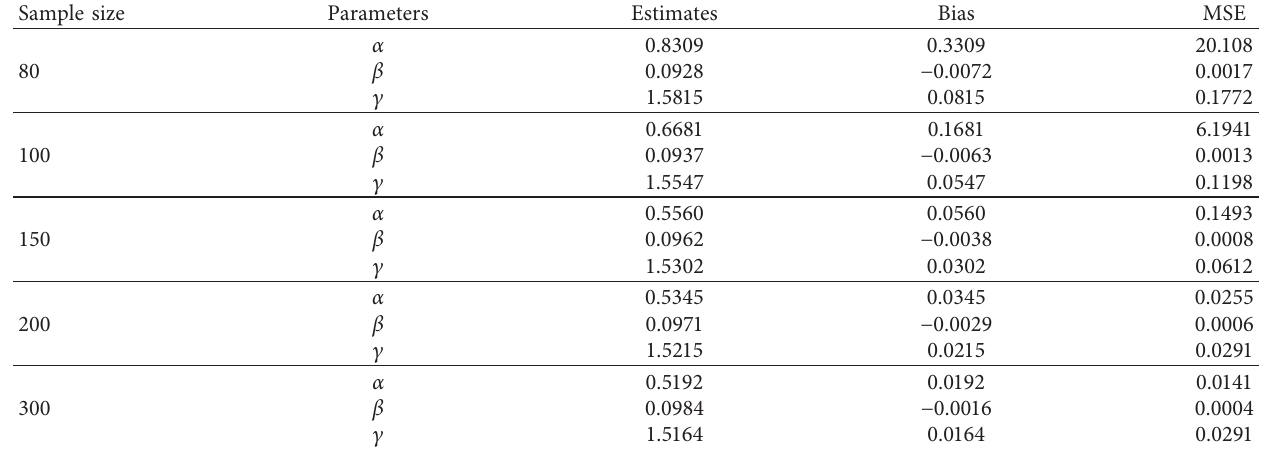
Table 3: Estimates of parameter, bias, and MSE at α � 0.5, β � 0.1, and c � 1.5.